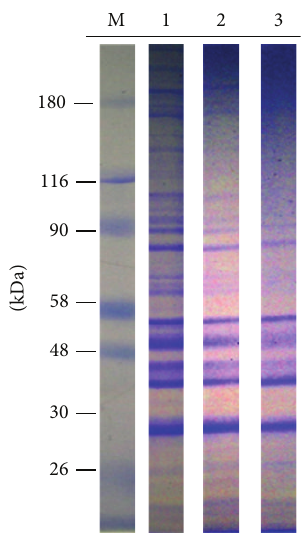
Figure 2: Protein profile of cells exposed to SeMet and SSe: controls (Lane 1) cells treated with 0.5 mM SeMet (Lane 2) and SSe (Lane 3) for 48h; standard molecular mass markers (M) are shown in the first